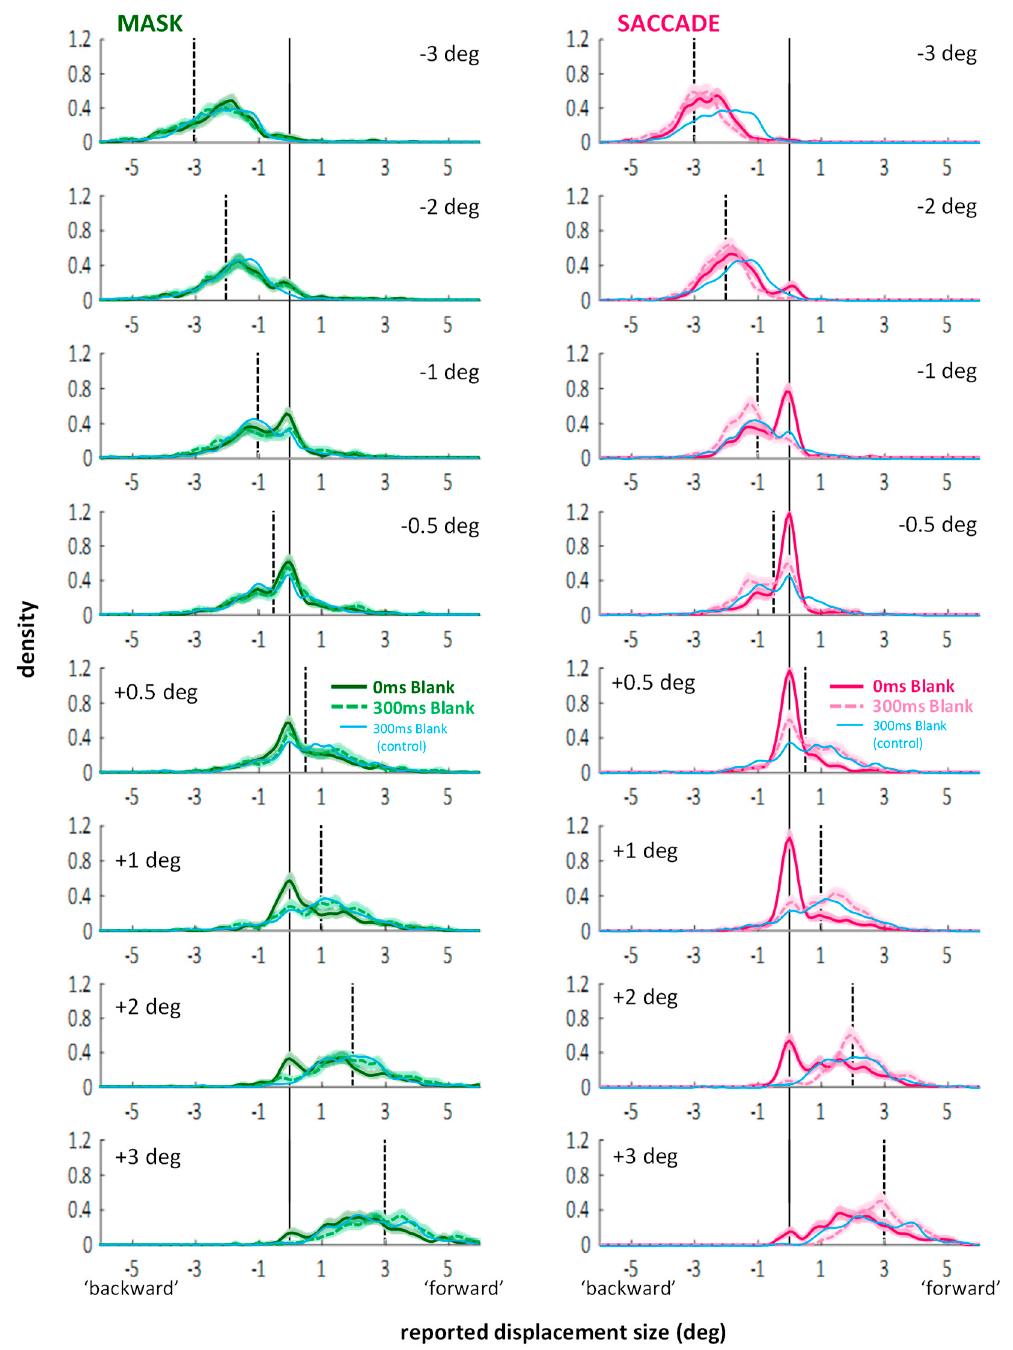
Figure A2. Distribution of responses (kernel density functions) in the mask (left) and saccade (right) conditions of Experiment 2. Continuous lines: no blank conditions, dashed lines: blank conditions. Thin blue lines represent data from the 300 ms blank condition during fixation from Experiment 3.